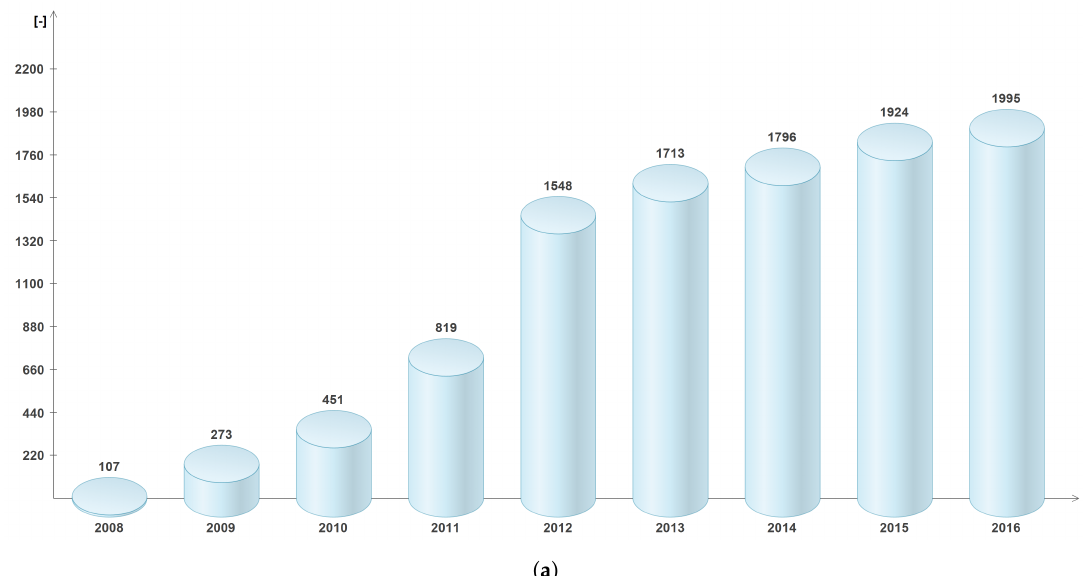
Figure 7. Number of plants, Electricity generation and Installed Electricity Capacity in the top fourth EU countries in 2016. Data from: Reference [45].